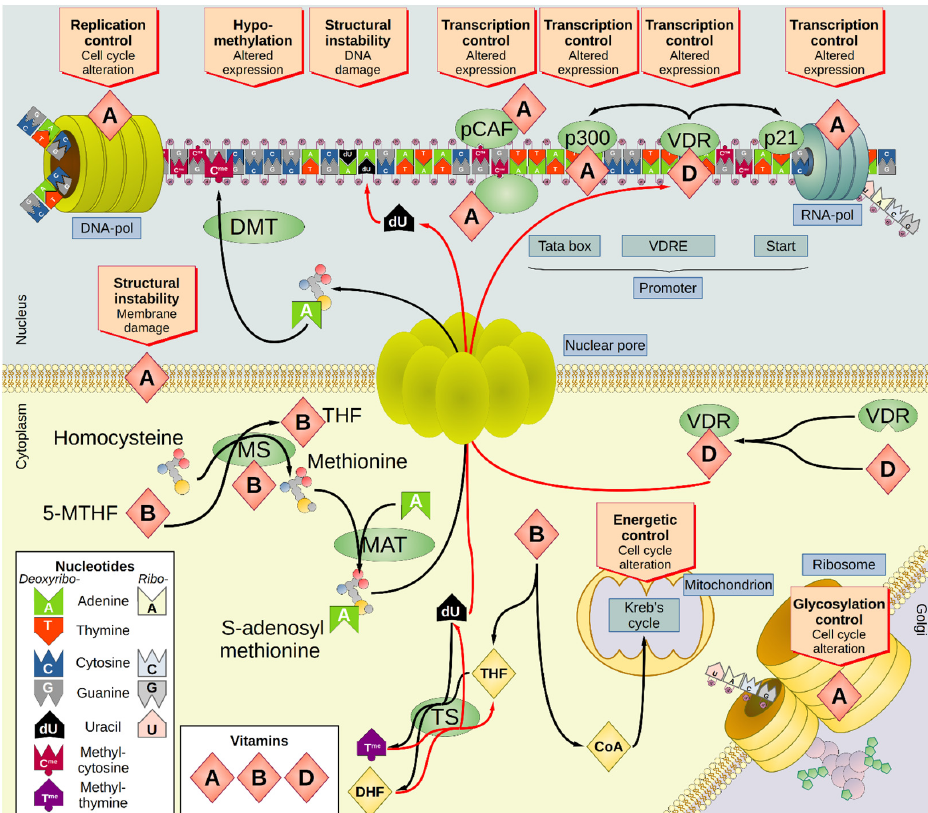
Figure 1. Overview of the impact of vitamins A, B complex, and D on the cellular biochemistry. The